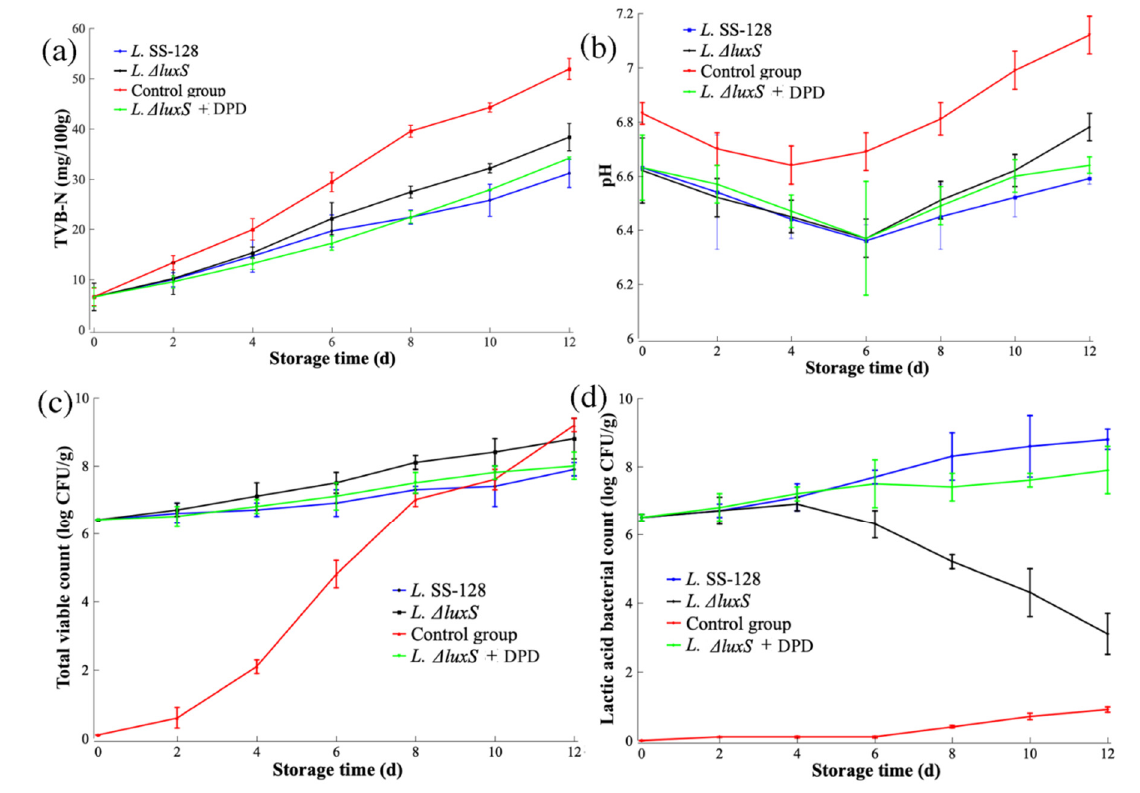
Figure 5. Changes in Litopenaeus vannamei during preservation. ( a ) TVB-N; ( b ) pH; ( c ) TVC; ( d ) lactic acid bacterial count.